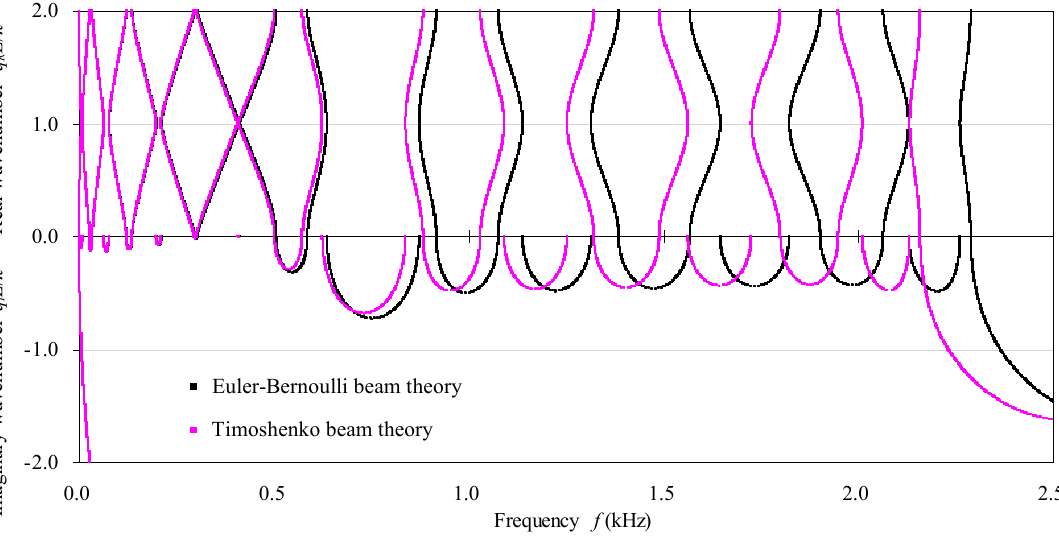
Figure 9. The comparison of band structures of the defected phononic crystal beam as a supercell within f ≤ 2.5 kHz by the MRRM based respectively on the Timoshenko and Euler–Bernoulli beam theories.